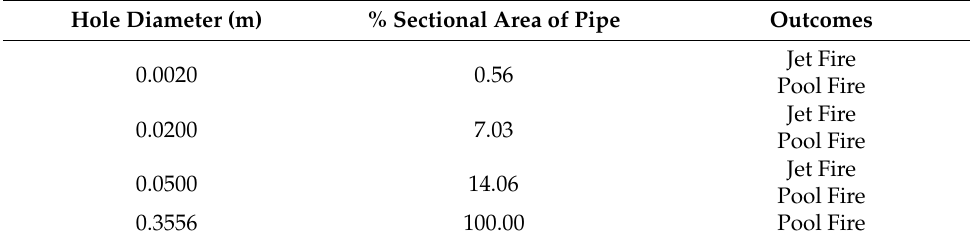
Table 2. Hazard scenarios considered for the case